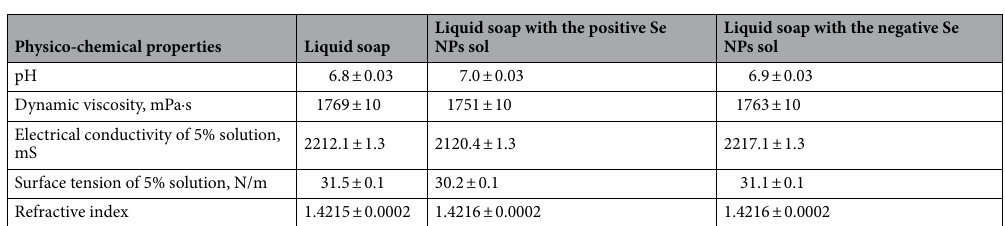
Table 1. Physicochemical properties of experimental samples of liquid